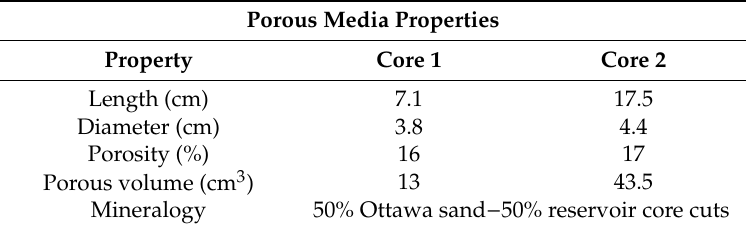
Table 2. Properties of the porous media used for the surfactant and nanofluid injection.